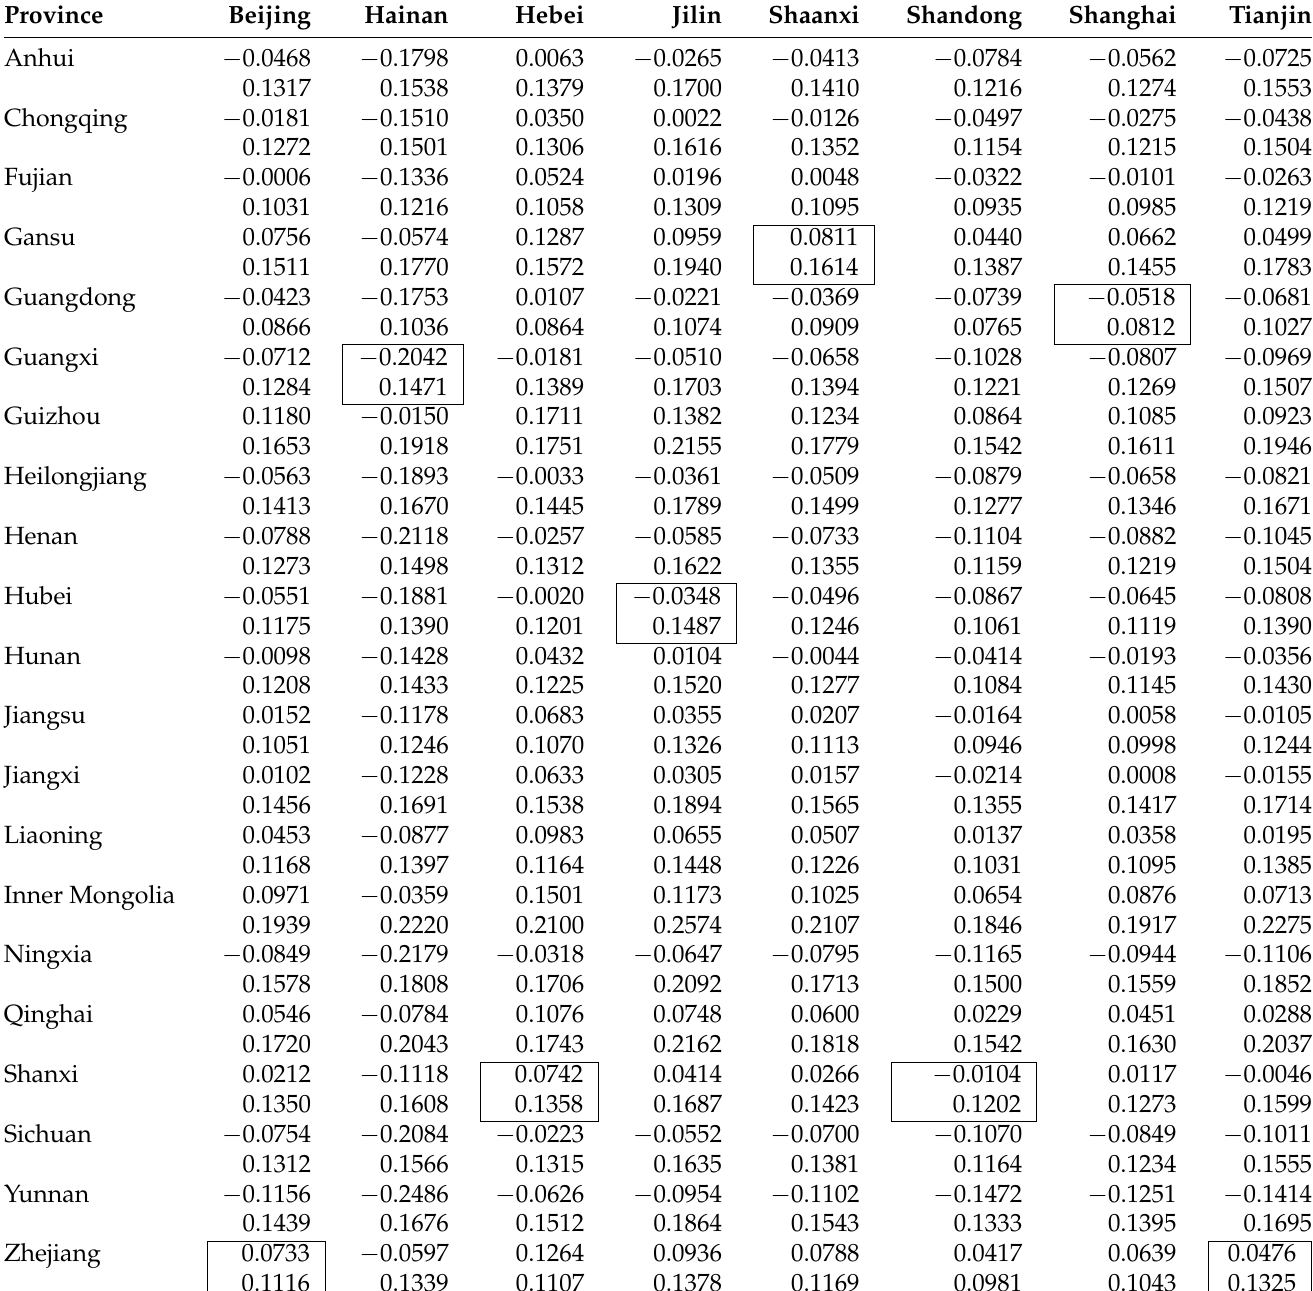
Table 6. ATET estimates (with corresponding standard error listed beneath) for each treated (column) vs each control (row) province (for all individuals) for the number of working hours per working day: Significance of point estimates at the arbitrary 1, 5 and 10 percent levels are colored red, blue and green, respectively—a box is given for the control province most closely aligned with the treatment province in terms of absolute minimum